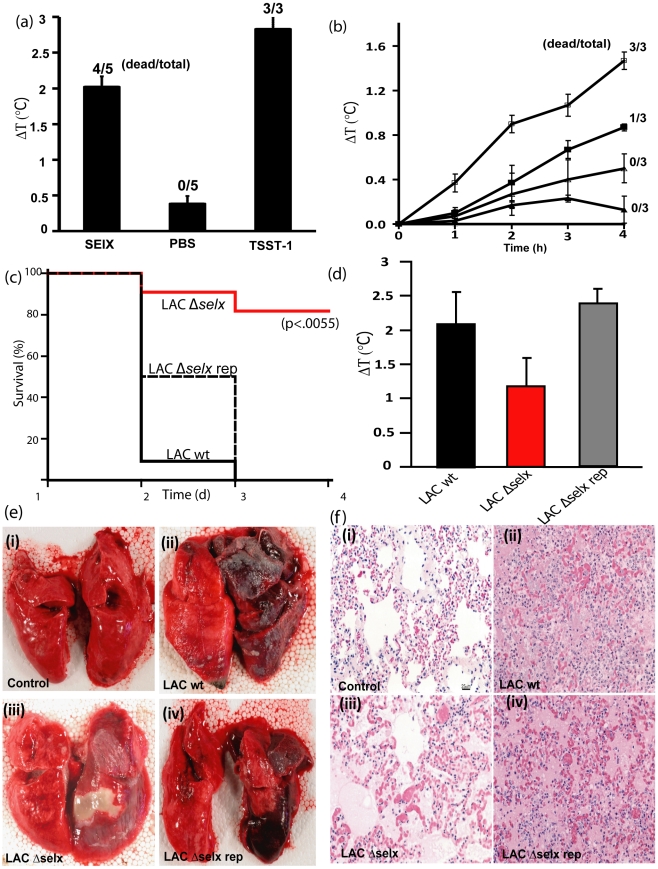
SElX causes TSS and contributes to the severity and lethality of necrotizing pneumonia caused by CA-MRSA USA300.
A) The ability of rSElX2, administered at a dose of 200 µg/kg, to cause TSS was measured using a standard miniosmotic pump model of TSS. TSST-1 administration was used as the positive control and PBS the negative control. B) Fever in response to intravenous injection of rSElX2 at concentrations of 10 µg/kg (□), 1 µg/kg (▪), 0.1 µg/kg (Δ), of body weight per ml, or PBS (▴), was evaluated over a 4 h test period, followed by the ability to enhance the lethality of LPS over 48 h. C) Kaplan-Meier Curves of % survival of rabbits infected with S. aureus LAC, S. aureus LACΔselx, and LACΔselx rep. D). Increase in rabbit core temperature (ΔT °C) 2 d after pulmonary infection with LAC wt, LACΔselx, and LACΔselx rep. E). Gross pathology of lungs from uninfected rabbit (i) or from rabbits infected with LAC wt (ii), LACΔselx (iii), and LACΔselx rep (iv). F) Haematoxylin Eosin-stained tissue sections from (i) uninfected rabbit lung, or from rabbit lungs infected with (ii) LAC wt, (iii) LACΔselx and (iv) LACΔselx rep isogenic strains.